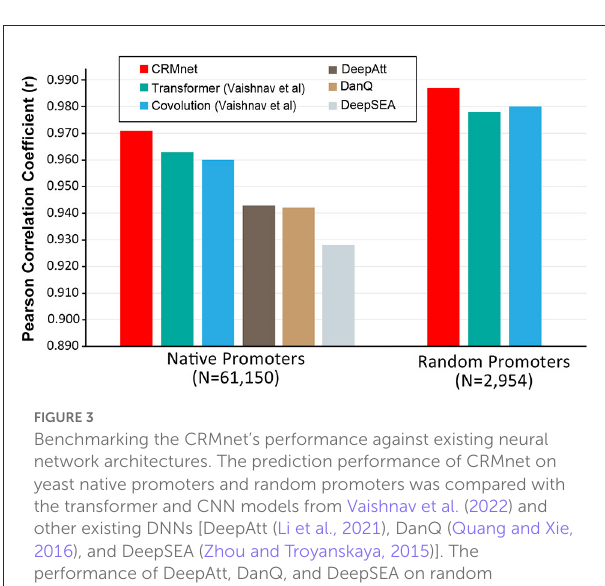
FIGURE3 Benchmarking the CRMnet’s performance against existing neural network architectures. The prediction performance of CRMnet on yeast native promoters and random promoters was compared with the transformer and CNN models from Vaishnav et al. (2022) and other existing DNNs [DeepAtt ( Li et al., 2021), DanQ (Quang and Xie, 2016), and DeepSEA (Zhou and Troyanskaya, 2015)]. The performance of DeepAtt, DanQ, and DeepSEA on random promoters was not published in Vaishnav et al.